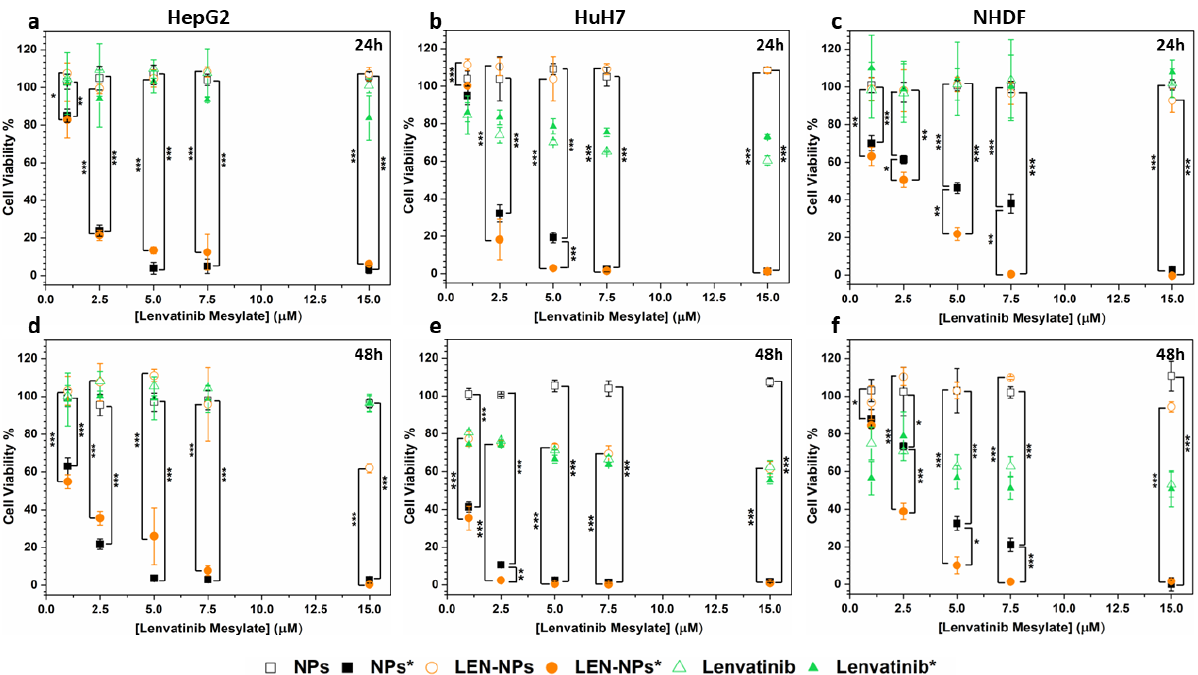
Figure 10. LEN-NPs dual-mode cytotoxicity studies on HepG2 (panel ( a , d )), HuH7 (panel ( b , e )) and NHDF (panel ( c , f )) after 24 h (panel ( a – c )) and 48 h (panel ( d – f )) of incubation with different samples(*: NIR laser treated) (* p < 0.05, ** p < 0.01, *** p < 0,005).